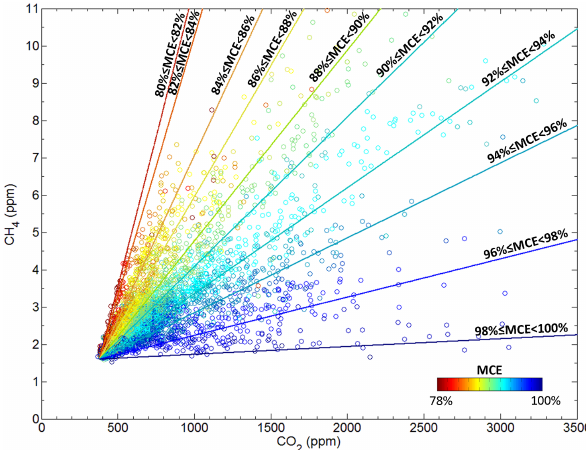
Figure 12. Same as Fig. 11a, but with all data from the 2009 and 2010 campaigns, including generalised least squares linear best-fit lines that have been calculated using measurements sub-sampled by narrow (2%) bins of MCE. Each line represents the line of best fit to the sub-sampled emission measurements (the MCE bin for each line is indicated on the plot). Similar plots for other gas species can be found in Supplement Figs. S1 and S2.